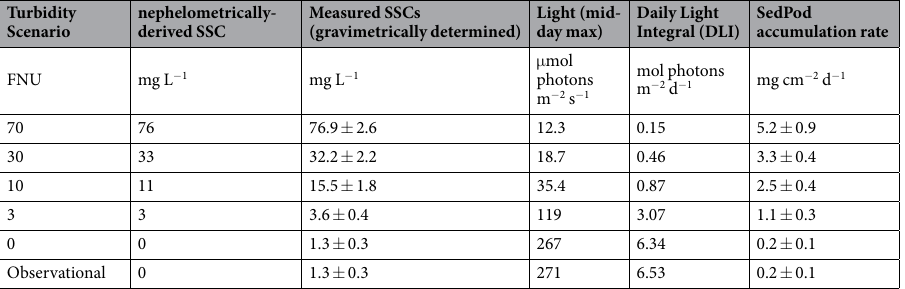
Table 1. Summary of exposure scenarios. Turbidity (FNU), mean nephelometrically-derived SSC (mg L − 1 ), measured SSCs determined gravimetrically at 7, 14, 21 and 28 d (mean ± SE, n = 3 samples per tank and day), maximum daily (mid-day) light level (instantaneous), daily light integral (DLI) and SedPod accumulation rate determined gravimetrically at 7, 14, 21 and 28 d (mean ± SE, n = 2 samples per tank and day), during the 28 d experimental period and subsequent 14 d observational period. Scenarios were based on in situ water quality data collected from three recent large scale capital dredging programs in Australia 5, 6 (see